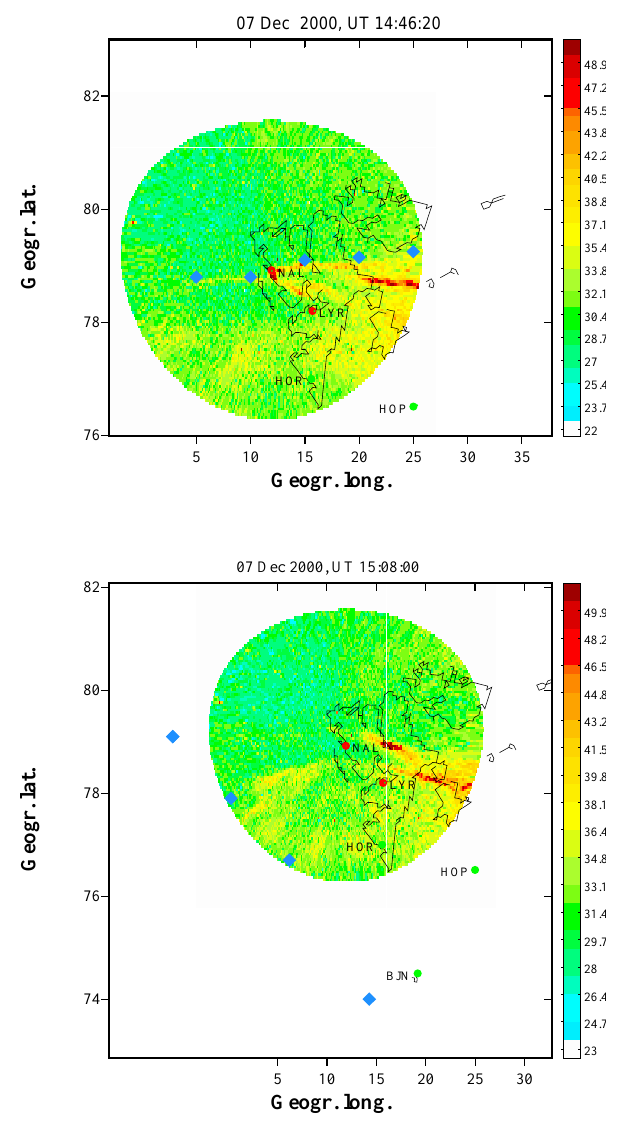
Fig. 5. Mapped ASC images (wavelength 557.7nm, intensity in ADUs) recorded by ITACA at Ny ˚ Alesund at 14:46:20, and 15:08:00 UT. The altitude of the auroras is assumed to be 110 km. The diamonds in the upper plot delineate the poleward edge of the auroras and in the lower plot they show the DMSP F13 footpoints during 15:06–15:08 UT (Fig. 5). In the lower plot, the second dia- mond from the top marks the poleward edge of the auroral precipi- tation observed by